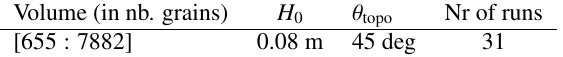
Table 1. Simulations performed Volume (in nb. grains)